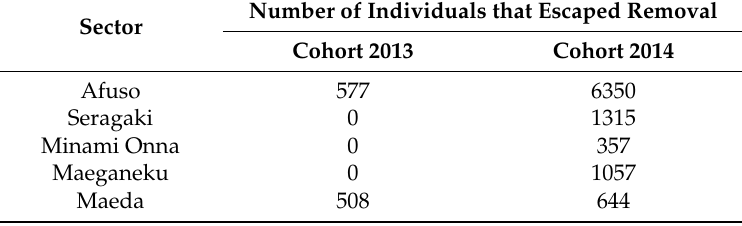
Table 5. The number of individuals that escaped removal, predicted from the best-fit models for the cohorts 2013 and 2014 for five sectors along the Onna coast, Okinawa, Japan.